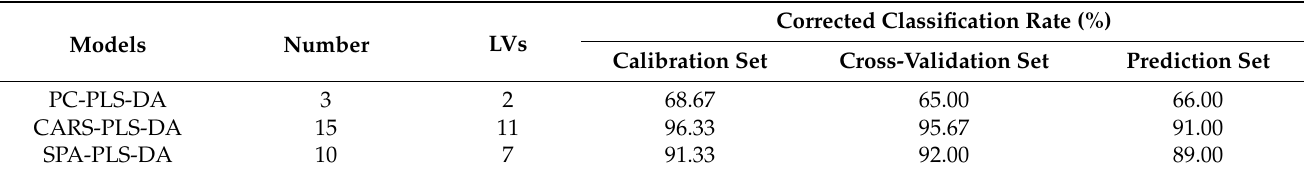
Table 3. The optimal PLS-DA modeling results developed by selected wavelengths based on different methods.